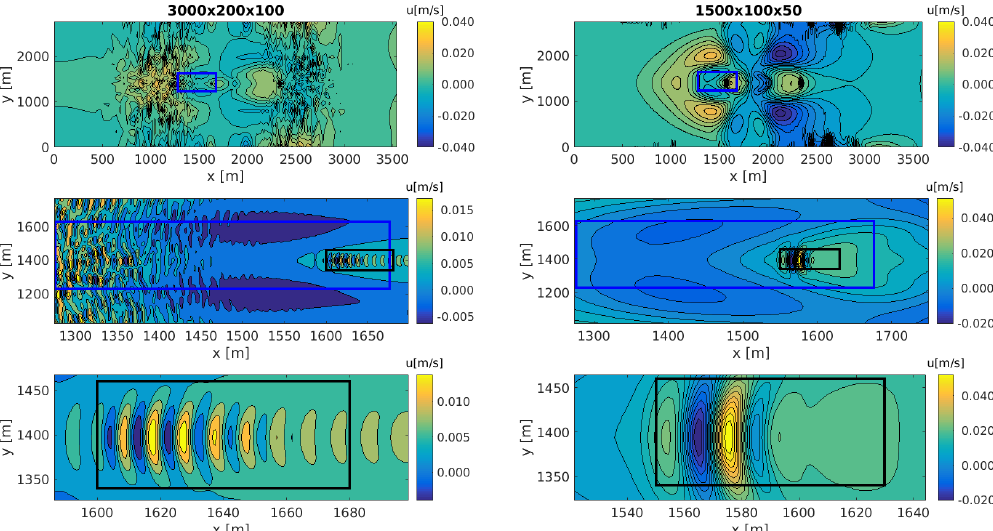
Figure 10. Figures depict zoomed-in details of the High ( left ) vs. Low ( right ) resolution bottom plane view for the stratified seamount experiment at t = 6000